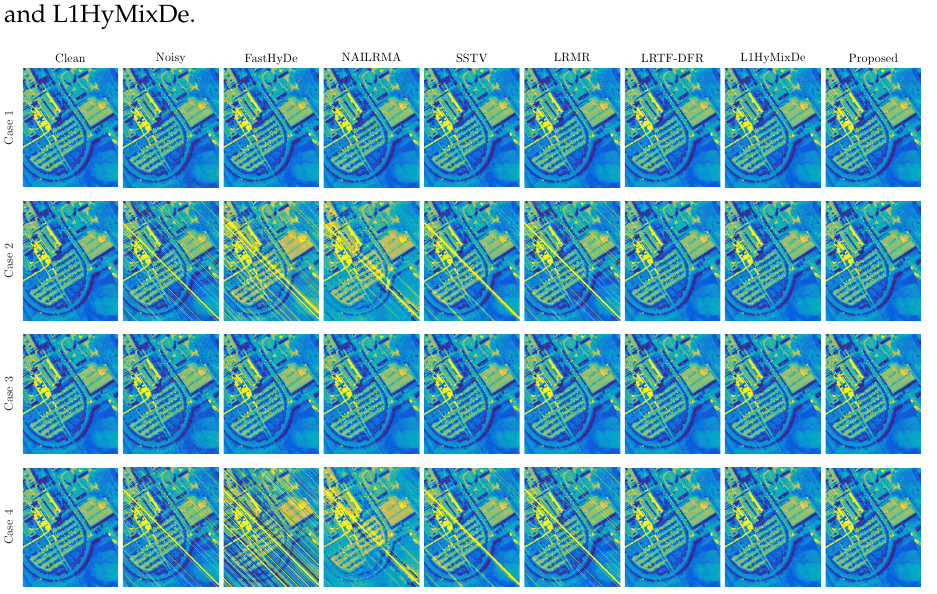
Figure 6. Band 37 of Pavia University data before and after denoising in four